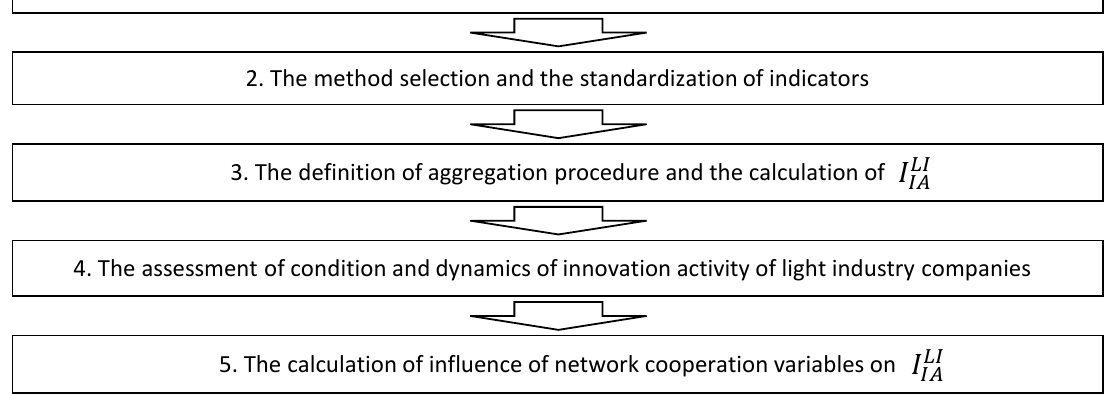
Figure 1. The sequence of calculation of the Innovation Index of companies taking into account the influence of network cooperation